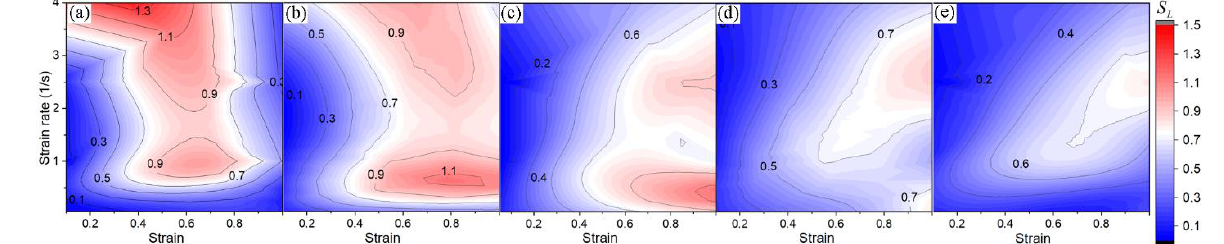
Figure 15. The effect of strain and strain rate on the fraction of low-angle boundaries L P depending on temperature, °C: ( a ) 300, ( b ) 350, ( c ) 400, ( d ) 450, and ( e ) 500. The dependences have been obtained from neural network predictions.